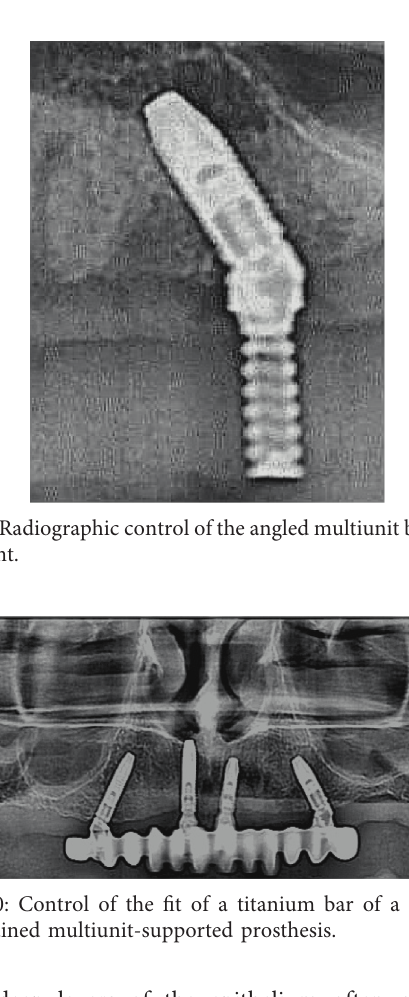
Figure 8: Straight and angled multiunit systems.